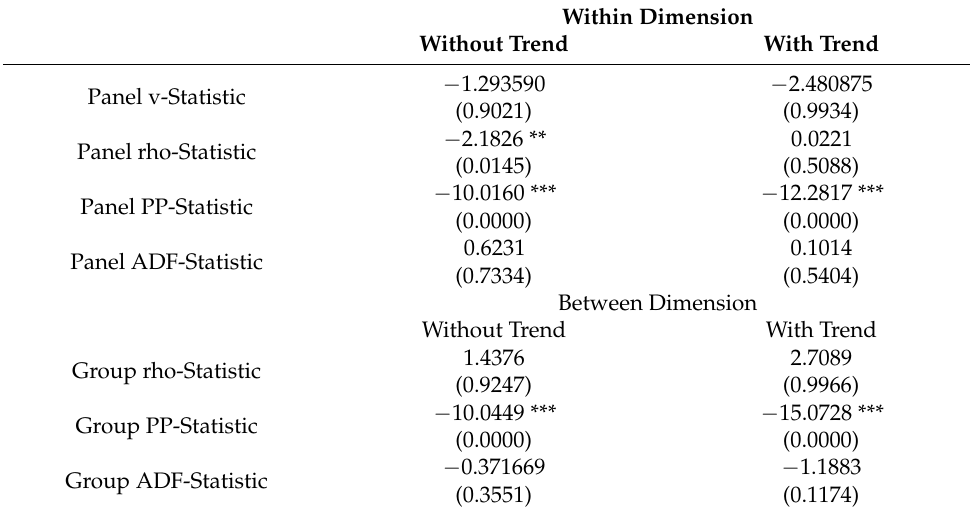
Table 5. Panel Co-integration